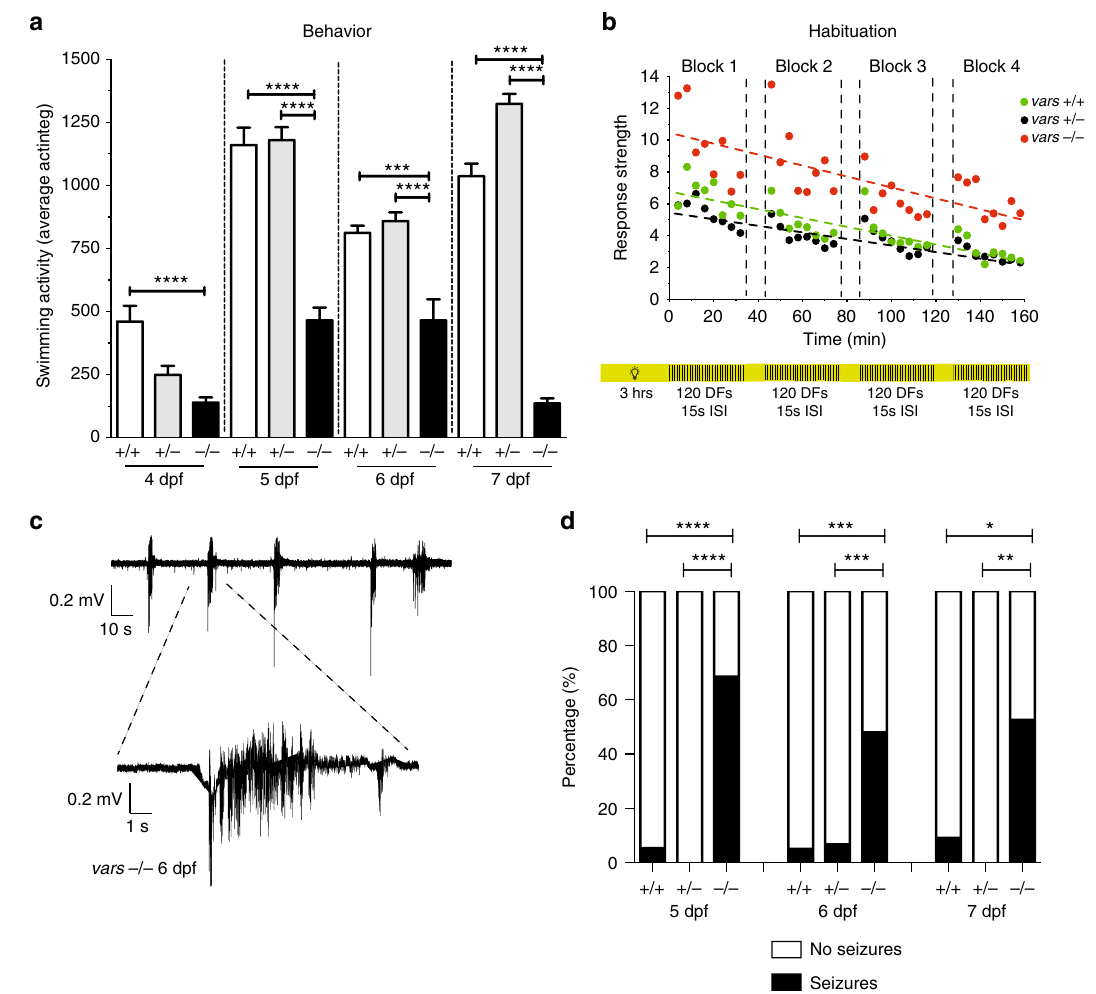
Fig. 4 vars − / − larvae show cognitive de fi cits and spontaneous seizure like behavior. a Behavioral activity (average total movement) of vars + / + ( n = 58), vars + / − ( n = 108), and vars − / − ( n = 58) larvae from 4 to 7 dpf expressed in actinteg units. Values are mean of three separate experiments. b Habituation assay performed on 6 dpf vars + / + ( n = 19), vars + / − ( n = 47), and vars − / − ( n = 30) larvae was composed of four blocks with 120 DFs with 15 s ISI (regions with black and yellow stripes), alternated by 10 min of light (yellow areas). The linear slopes between the actinteg responses were calculated (dotted lines) and compared between the different genotype groups (green circles — vars + / + , black circles — vars + / − , and red circles — vars − / − ). DF dark fl ashes, ISI interstimulus intervals. Values are mean of two separate experiments. c Representative recording from optic tectum of 6 dpf vars − / − larva displaying polyspike discharges. Top trace represents typical pattern of epileptiform activity. Bottom trace shows magni fi cation of the epileptiform event. d Percentage of larvae exhibiting spontaneous electrographic activity recorded from 5 dpf vars + / + ( n = 19), vars + / − ( n = 31), and vars − / − ( n = 35), 6 dpf vars + / + ( n = 20), vars + / − ( n = 30) and vars − / − ( n = 48) and 7 dpf vars + / + ( n = 12), vars + / − ( n = 13) and vars − / − ( n = 19) larvae. Abnormal brain activity was observed in 68.57% (24/35) 5 dpf vars − / − , 5.26% (1/19) 5 dpf vars + / + , 47.62% (23/48) 6 dpf vars − / − , 5% (1/20) 6 dpf vars + / + , 6.67% (2/30) vars + / − , 52.63% (10/19) 7 dpf vars − / − and 8.33% (1/12) 7 dpf vars + / + . In a and b one-way ANOVA with Tukey ’ s